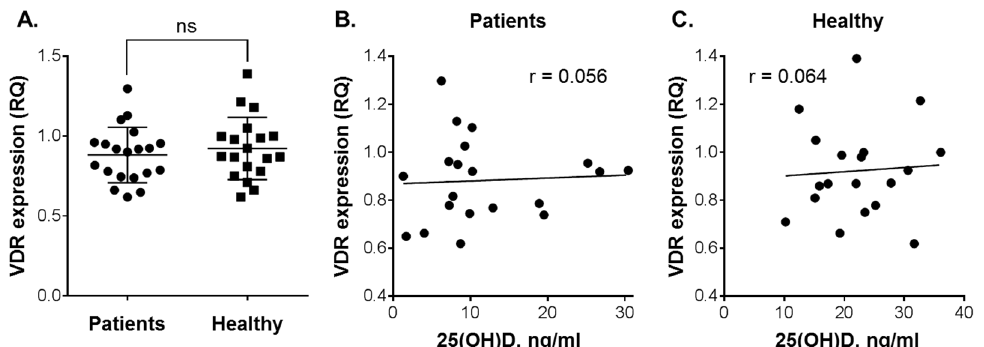
Figure 4. Vitamin D receptor (VDR) expression in peripheral blood mononuclear cells (PBMC) vs. 25(OH)D levels in the plasma of patients with leukemia and healthy subjects. ( A ) Comparison of VDR expression between patients ( n = 20) and healthy individuals ( n = 19). Data are the means (long horizontal lines) ± SD. Correlation analysis of VDR expression and 25(OH)D levels in patients ( B ) and healthy subjects ( C ); ns, not significant; r, correlation coefficient.